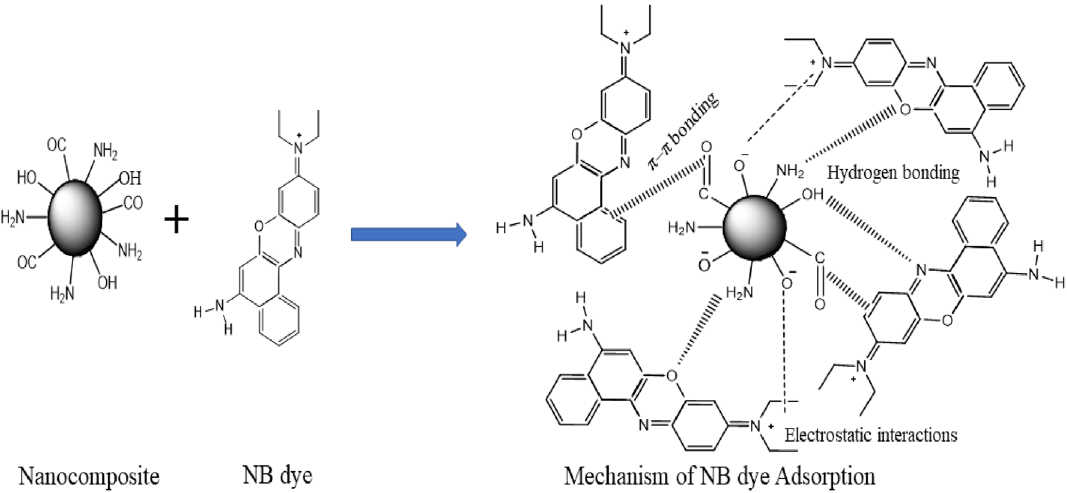
Scheme 1. Schematic representation of the plausible interactions of NB with GG-PAAm/Er 2 O 3